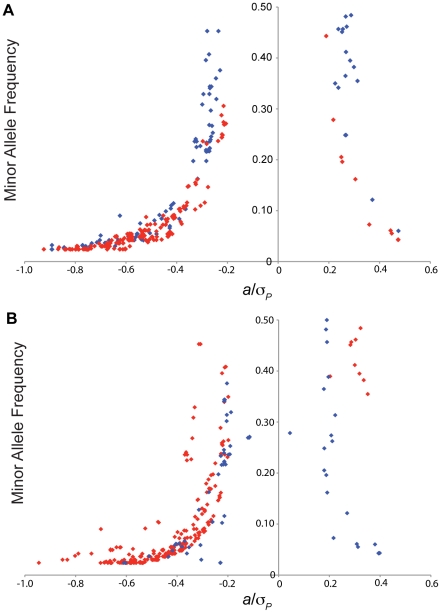
Minor allele frequency versus effect size.All main SNP effects and corresponding minor allele frequencies are shown. (A) Main SNP effects across sexes (females, males and sexes pooled) for each treatment. Survival on paraquat is depicted by red dots, survival on MSB by blue dots. (B) Main SNP across treatments (paraquat, MSB, and treatments pooled) effects for each sex. Females are depicted by red dots, males by blue dots.